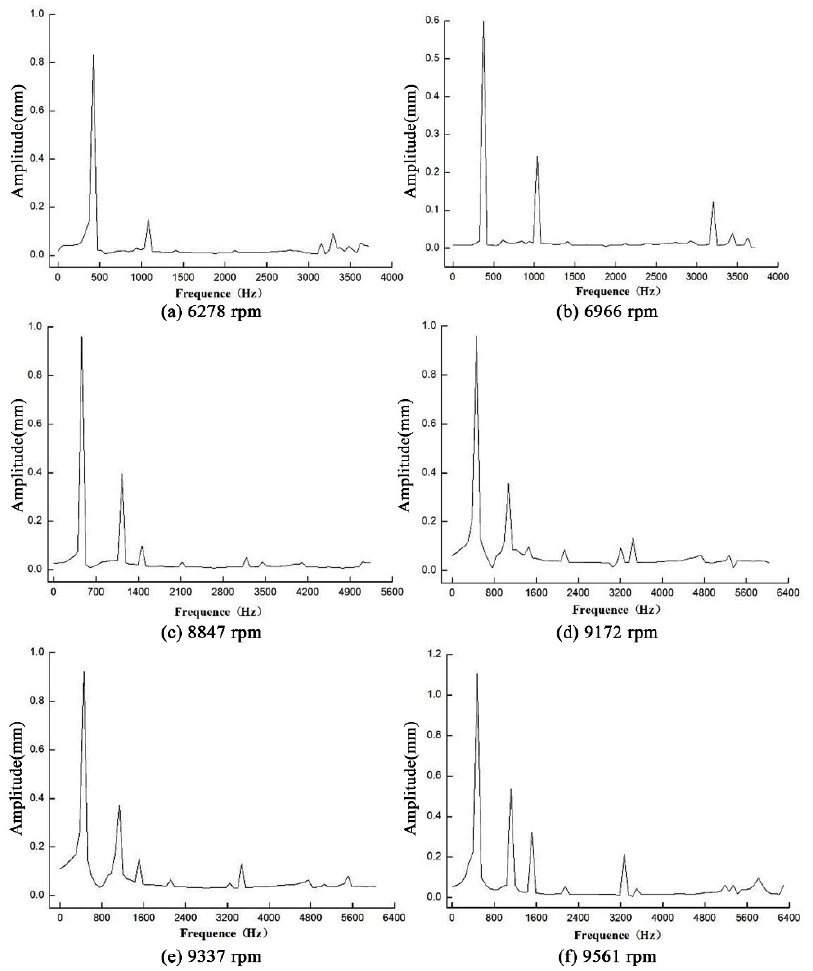
Figure 12. Spectrum values of natural frequency and displacement response under typical speed conditions. ( a ) 6278 rpm; ( b ) 6966 rpm; ( c ) 8847 rpm; ( d ) 9172 rpm; ( e ) 9337 rpm; ( f ) 9561 rpm.